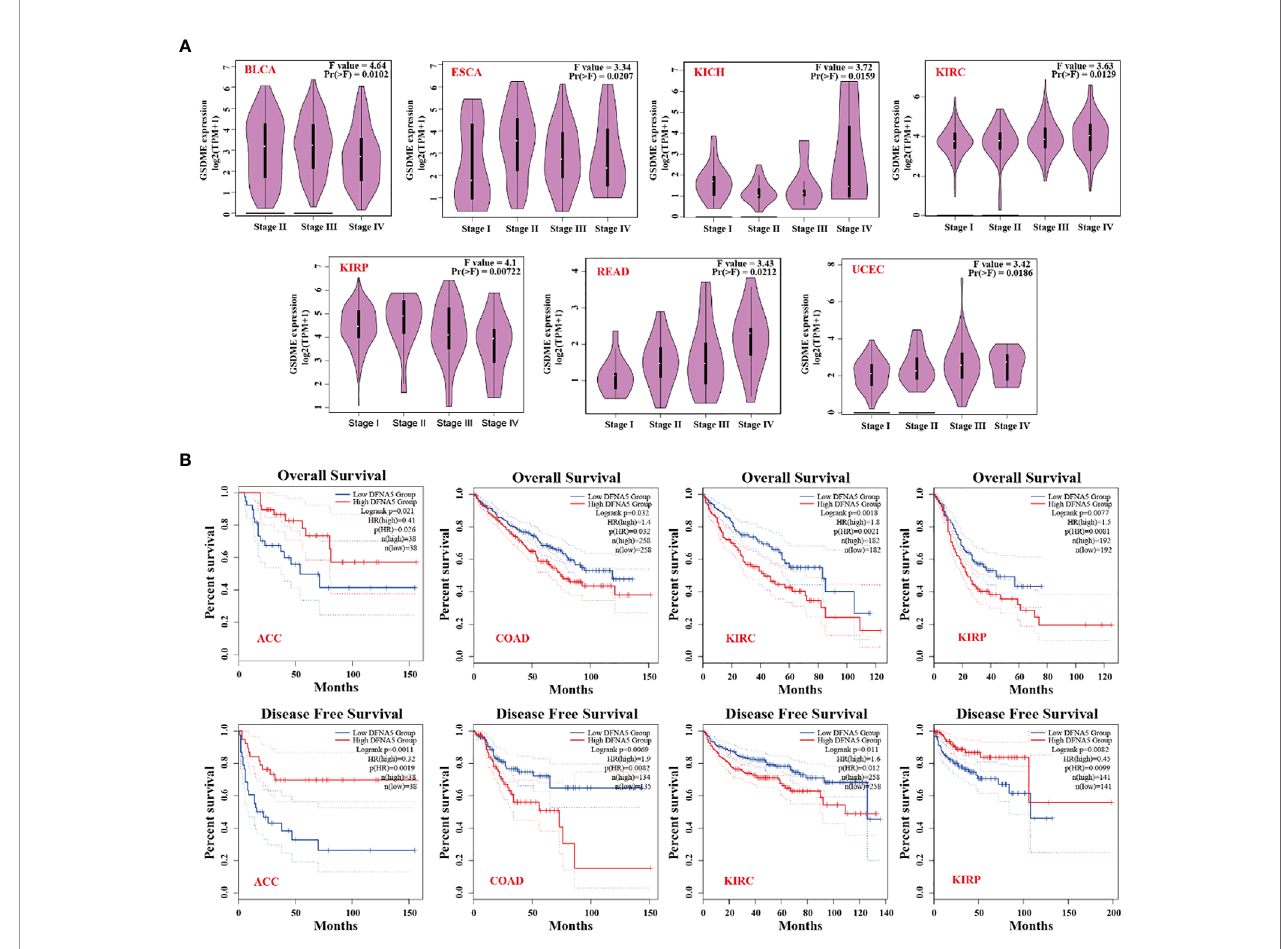
FIGURE 2 | (A) Expression status of GSDME in various pathological stages (stage I, stage II, stage III, and stage IV) of BLCA, ESCA, KICH, KIRC, KIRP, READ, and UCEC. (B) Correlation of GSMDE expression with overall survival and disease-free survival across different TCGA